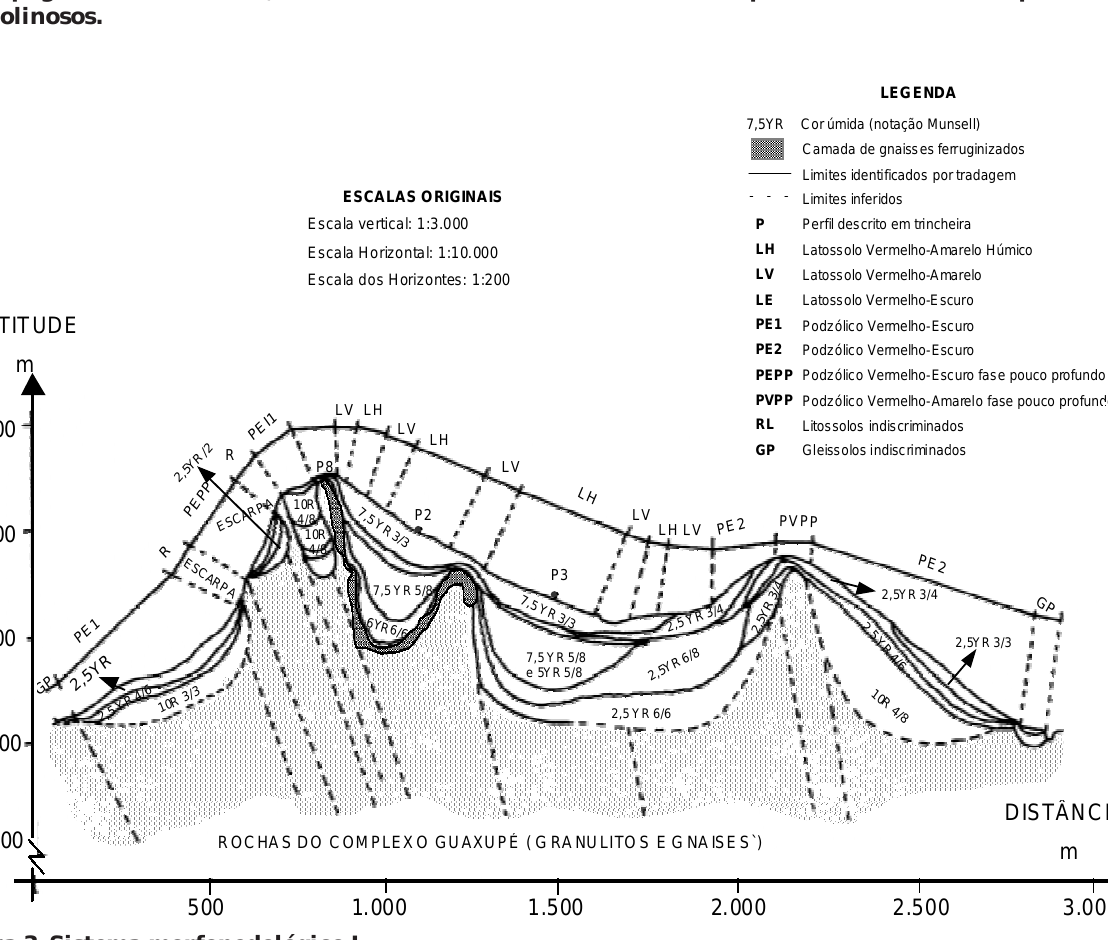
Figura 3. Sistema morfopedológico